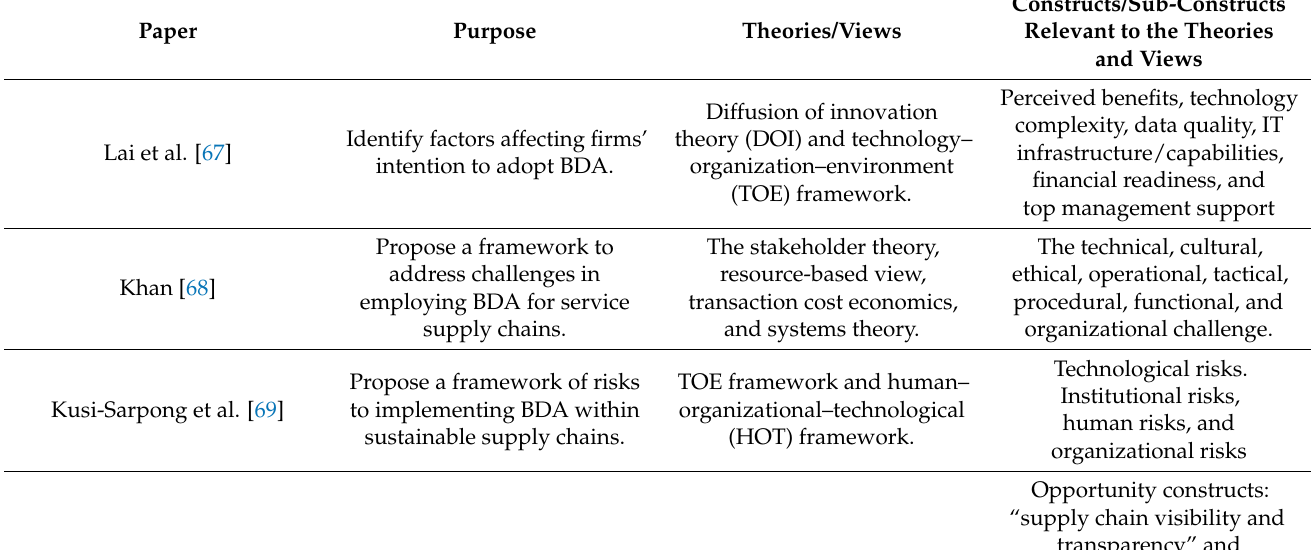
Table 6. Paper, purpose, theories/views, and constructs/sub-constructs of BDA implementation